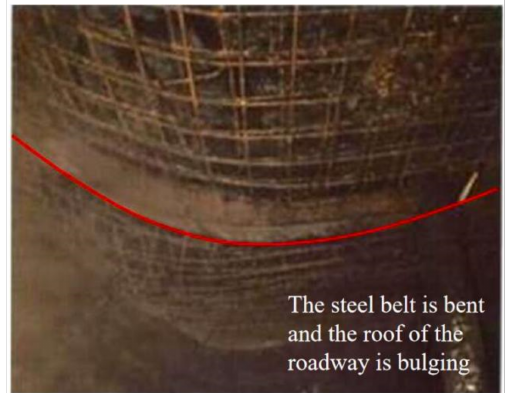
Figure 2. Deformation characteristics of the roadway.